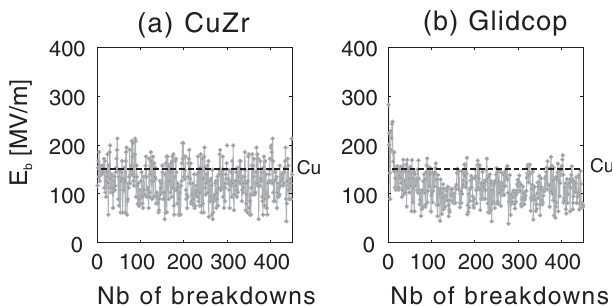
FIG. 3. Conditioning curves of copper-based materials.